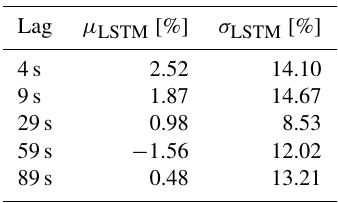
Table 2. Architecture of the first LSTM network with lag = 29s. Table 3. Sensitivity of the first LSTM model to the hindsight hori- zon, evaluated based on test